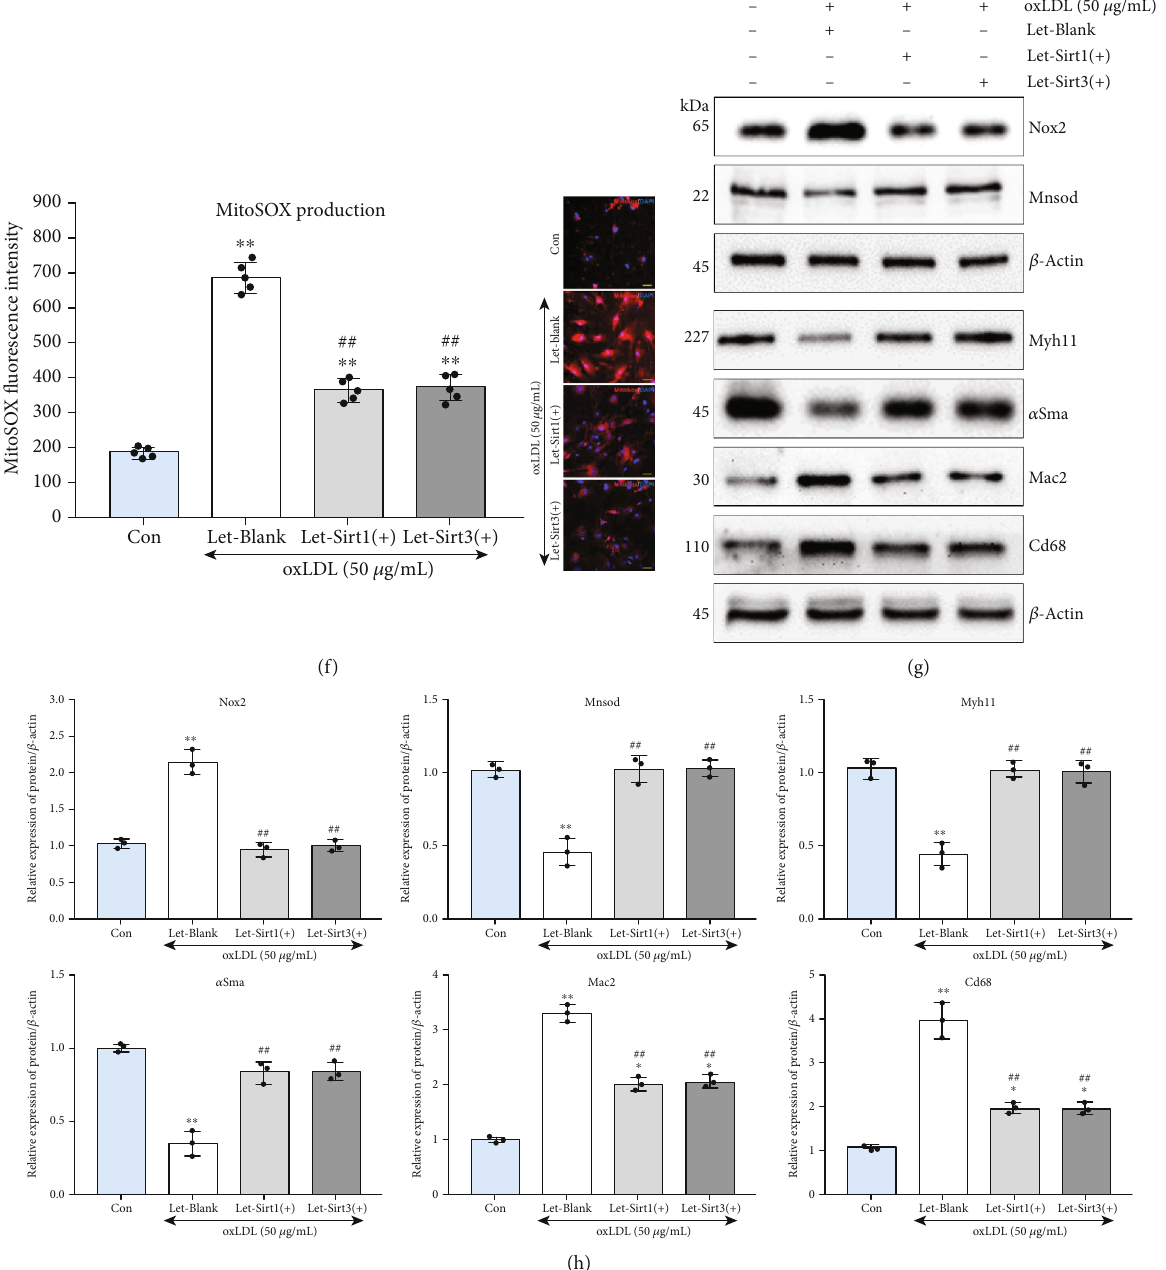
Figure 6: Overexpression of Sirt1 or Sirt3 inhibited oxLDL-induced ROS accumulation and altered cellular phenotype in VSMCs. All the western blot results were calculated using grayscale value, and β -actin served as an internal reference gene to normalize protein expression. (a, b) Tlr4(-) or NC VSMCs were treated with or without oxLDL (50 μ g/mL) for 48 hours; western blot was conducted to measure Sirt1, Sirt3, Nox2, and Monsod. ( n = 3 per group, results were expressed as mean ± SD ; ∗∗ P < 0 : 01 , as compared with oxLDL- untreated NC group; ## P < 0 : 01 , as compared with oxLDL-treated NC group.) The recombinant lentivirus of Sirt1 or Sirt3 has infected into VSMCs for Sirt1 and Sirt3 overexpression. The VSMCs were treated with or without 50 μ g/mL oxLDL for 48 hours. (c, d) The VSMCs were infected by recombinant lentivirus of Sirt1 [Let-Sirt1(+)] or Sirt3 [Let-Sirt3(+)], respectively, for 72 hours; afterwards, the overexpression e ffi ciency was detected. ( n = 3 per group, results were expressed as mean ± SD ; ∗∗ P < 0 : 01 , as compared with the Let-Blank group; ## P < 0 : 01 , as compared with Let-Sirt1(+) group.) (e) ROS (DCFH-DA, green) and (f) mitochondrial superoxide (MitoSOX, red) were measured. ( n = 5 per group, results were expressed as mean ± SD ; ∗∗ P < 0 : 01 , as compared with the control group (untreated group); ## P < 0 : 01 , as compared with Let-Blank group). (g, h) Western blot was conducted to measure the Nox2 and Mnsod (upper), as well as the VSMC contractile phenotype markers (Myh11 and α Sma) and foam cell markers (Mac2 and Cd68) (bottom). ( n = 3 per group, results were expressed as mean ± SD ; ∗ P < 0 : 05 , ∗∗ P < 0 : 01 , as compared with control group (untreated group); # P < 0 : 05 , ## P < 0 : 01 , as compared with Let-Blank